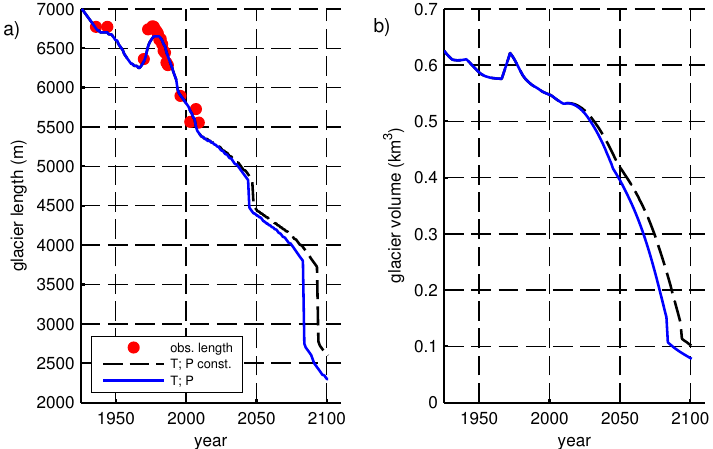
Fig. 13. Modelled (a) glacier length and (b) glacier volume of Glaciar Fr´ıas for the period 1925–2100. Glacier length and volume for the period 1925–2009 are calculated from the reconstructed mass balance profiles; for 2010–2100 the mass balance is calculated from the future scenario. The full scenario (increase in T of 2 ◦ C and decrease in P of 10% over the 21th century) is shown in blue. The length and volume change with precipitation kept at the 1980–2009 level are given in dashed black. In (a) also glacier length observations are included (red